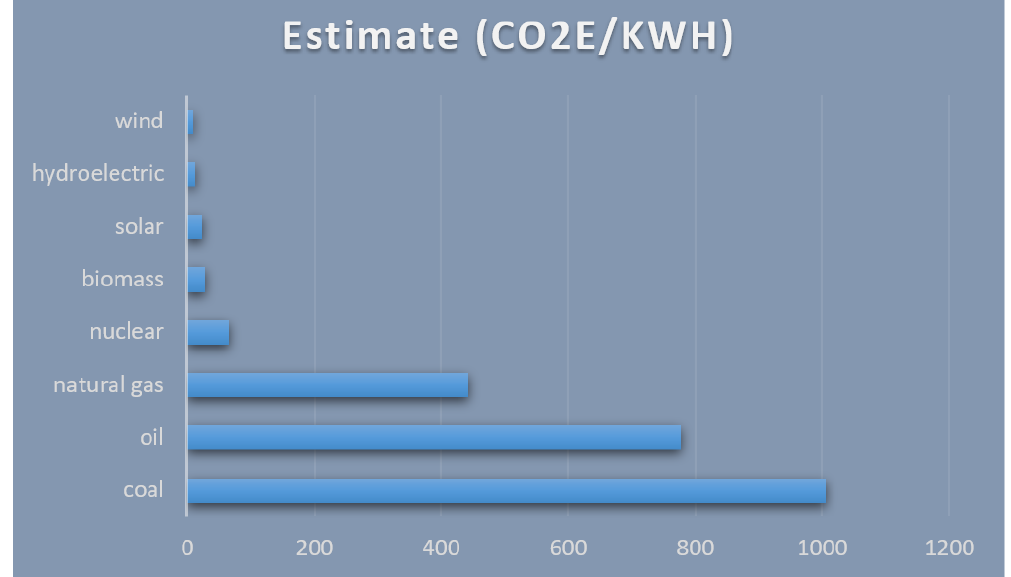
Figure 4: CO2 equivalent emissions [2]. Figure 4. CO 2 equivalent emissions